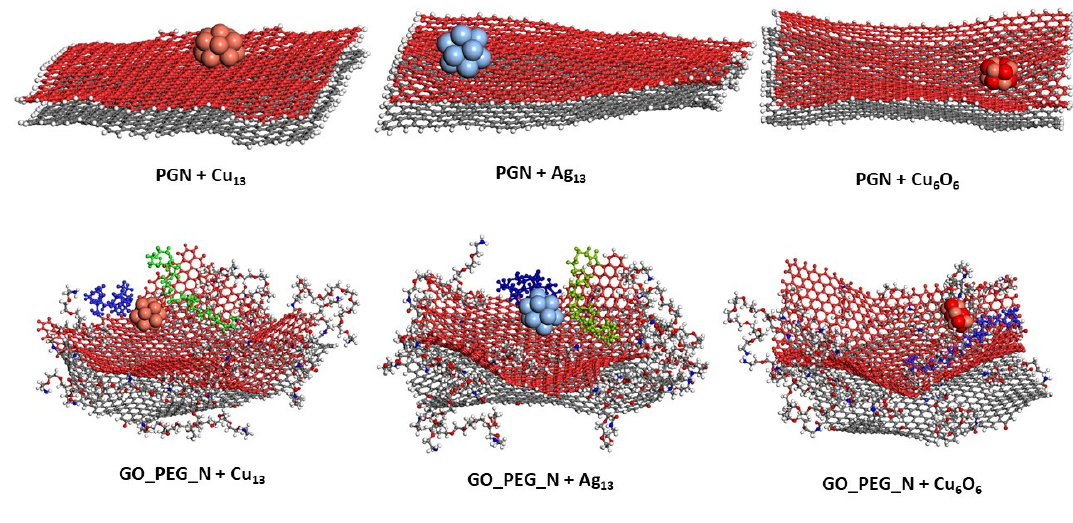
Figure 5. Representative position of the nanoclusters for pristine and functionalized graphene nanoplatelets after 10 ns of simulation length. The PEG chains closest to the nanoparticles are shown in blue and green.